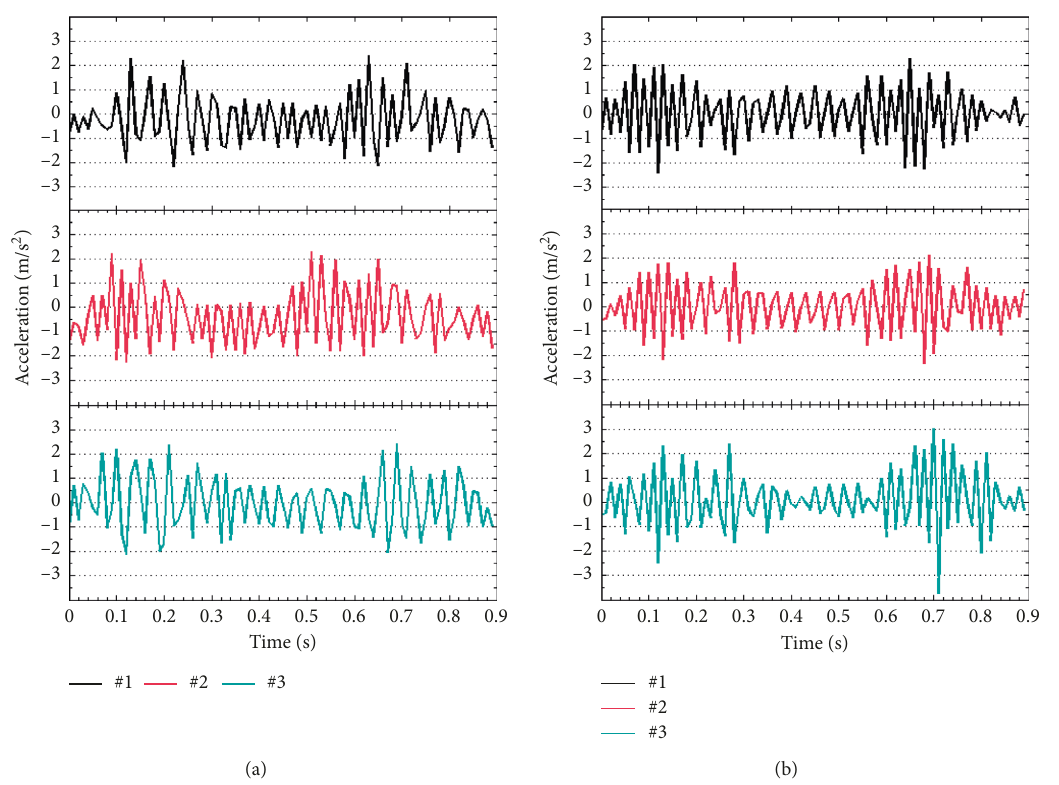
Figure 9: Vibration signals of different measuring points in Δ T : (a) experimental results; (b) simulation